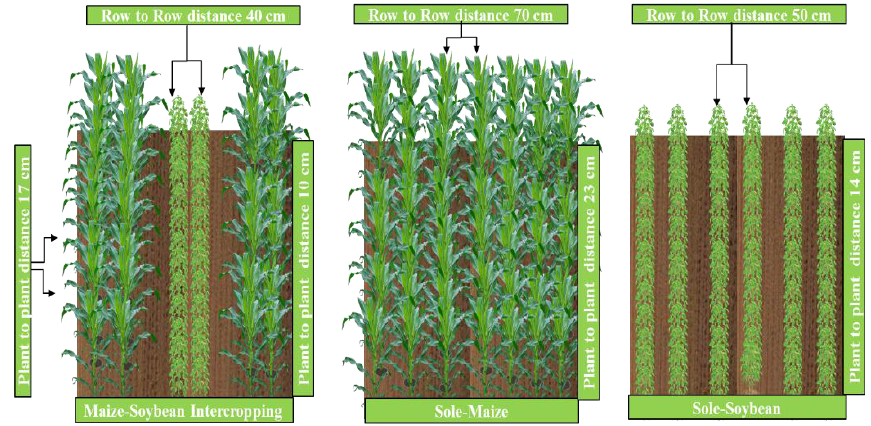
Figure 2. Schematic representation of maize–soybean intercropping system (MSI) from 2018 to 2019. Plant populations for sole maize and sole soybeans were similarly, maintained, keeping a distance of 16.7 cm and 20 cm, respectively. Both crops were planted simultaneously on the 10th ± 6 days of June. Maize was harvested in the last week of September, while the soybeans were harvested on the 28th ± 4 day of October in both years. Basal fertilizer application was also applied to maize at 130 and − 1 72 kg ha of nitrogen and phosphorus at planting time in sole and intercrops. The second